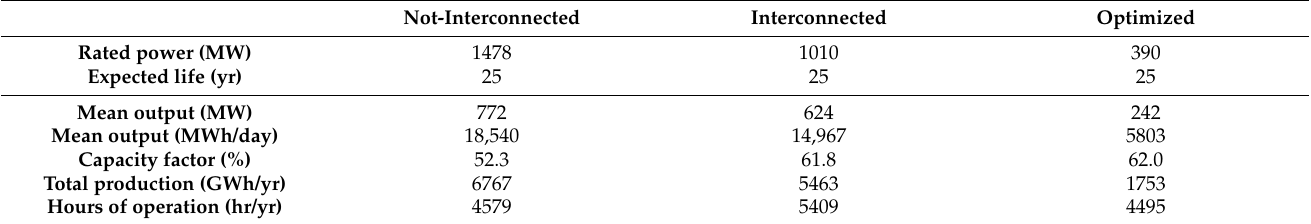
Table 12. Wind system summary.